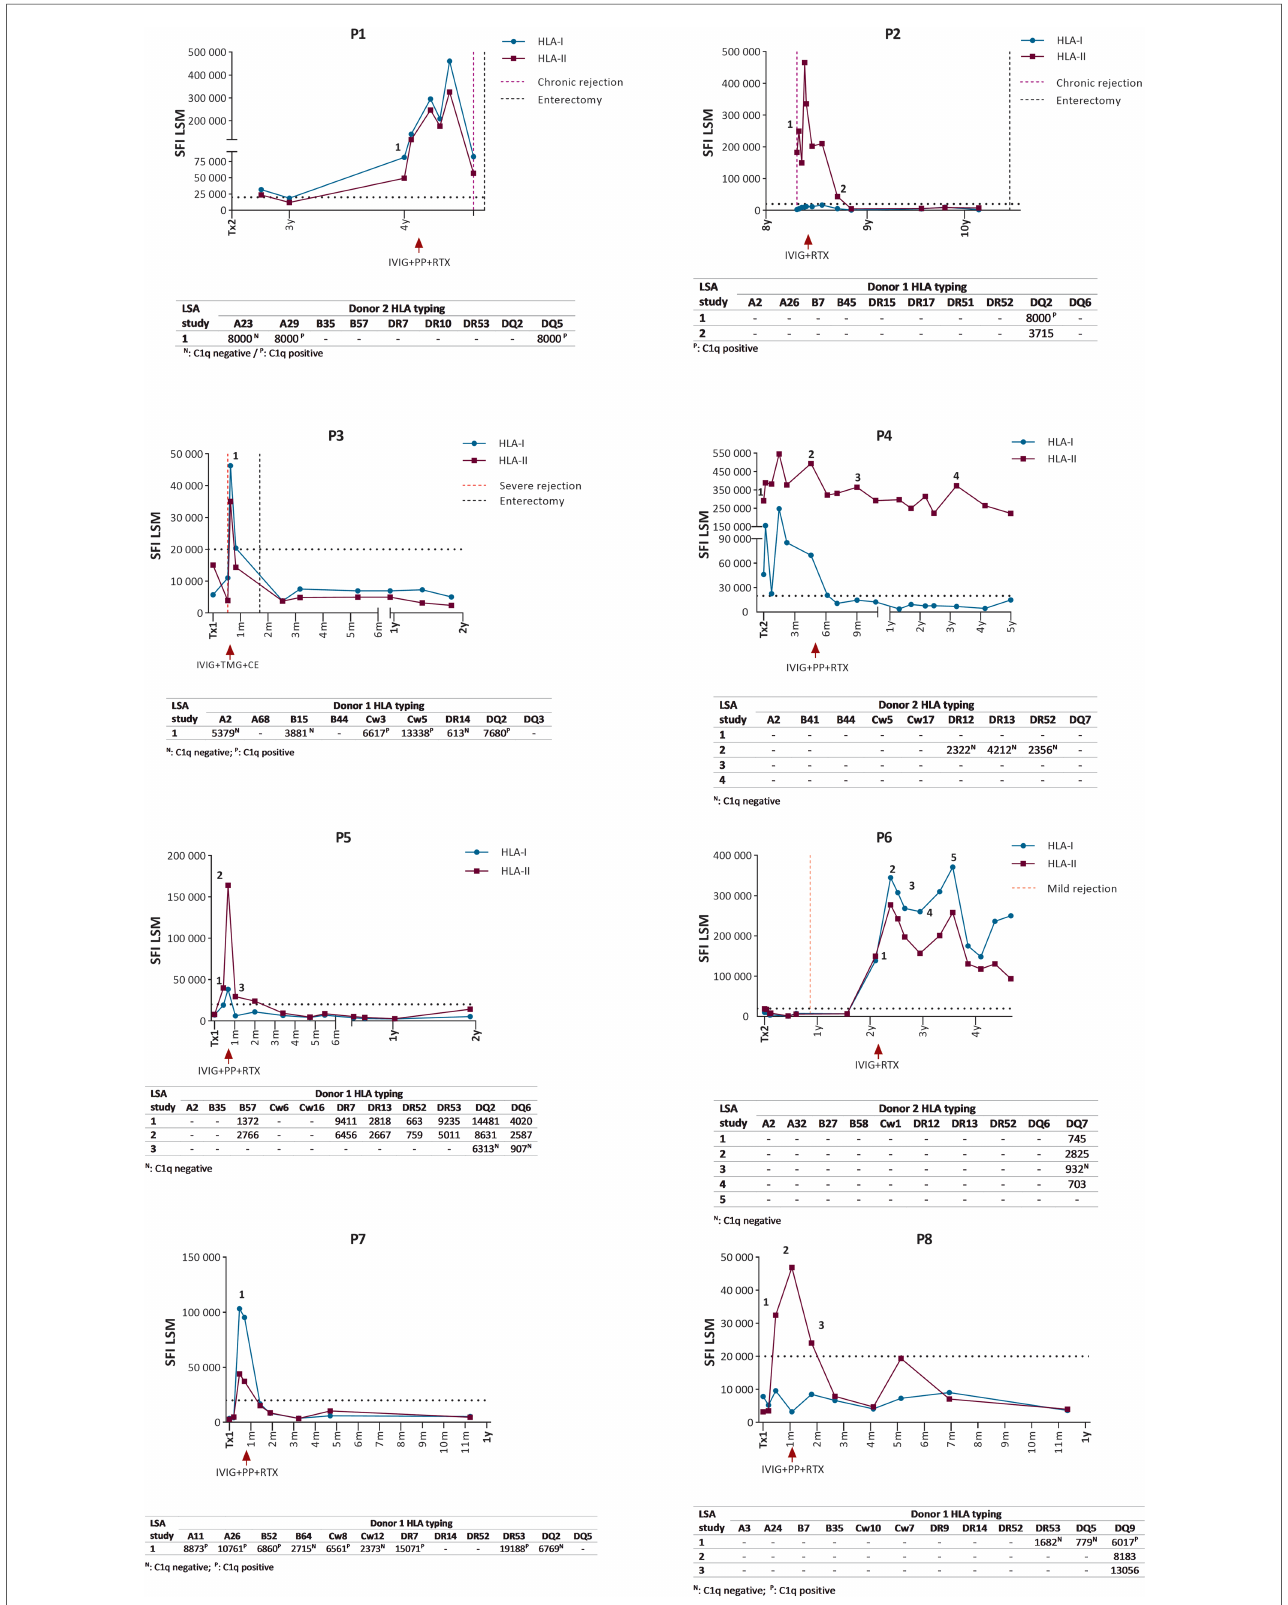
FIGURE 2 Evolution of anti-HLA antibodies levels (SFI) and DSA MFI in the eight treated recipients. Antibody-removal procedures and important clinical events are represented. CE, corticosteroids; HLA-I, anti-HLA class-I antibodies; HLA-II, anti-HLA class-II antibodies; IVIG, intravenous immunoglobulin; LSA, LABScreen single antigen; LSM, LABScreen Mix; PP, plasmapheresis; RTX, rituximab; TMG,